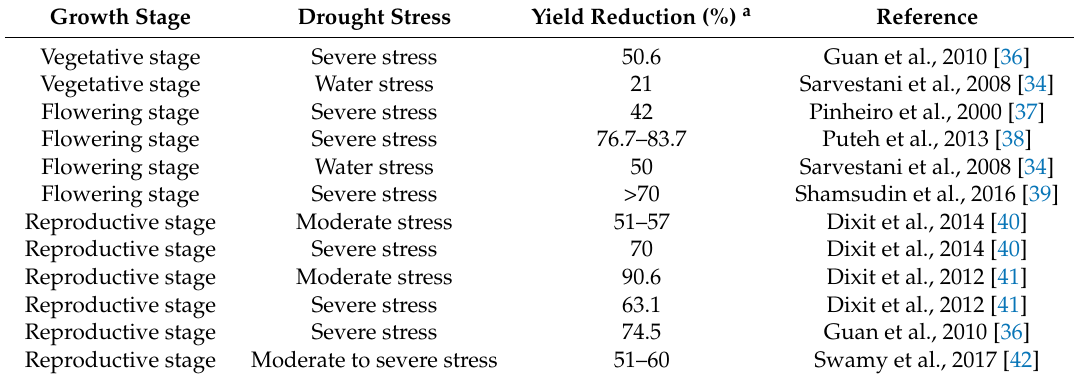
Table 4. Reductions in agronomic traits in rice caused by drought